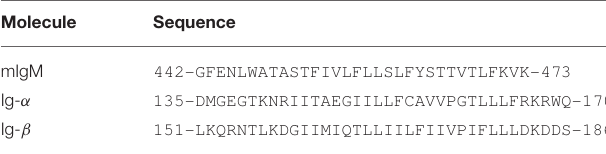
TABLE 1 | Amino acid sequences of the transmembrane domains of mIgM, Ig- α , and Ig- β studied in coarse-grained and atomistic MD simulations. Molecule Sequence mIgM 442-GFENLWATASTFIVLFLLSLFYSTTVTLFKVK-473 Ig- α 135-DMGEGTKNRIITAEGIILLFCAVVPGTLLLFRKRWQ-170 Ig- β